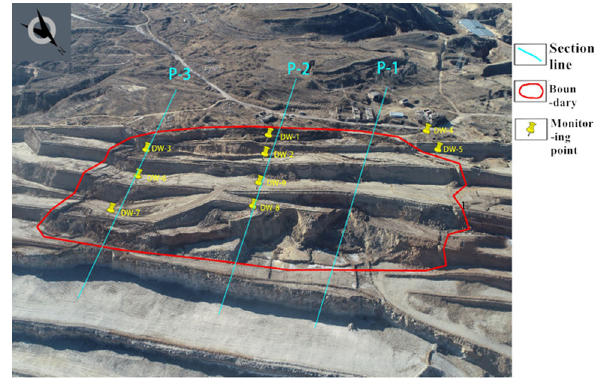
Fig. 2 Section location diagram